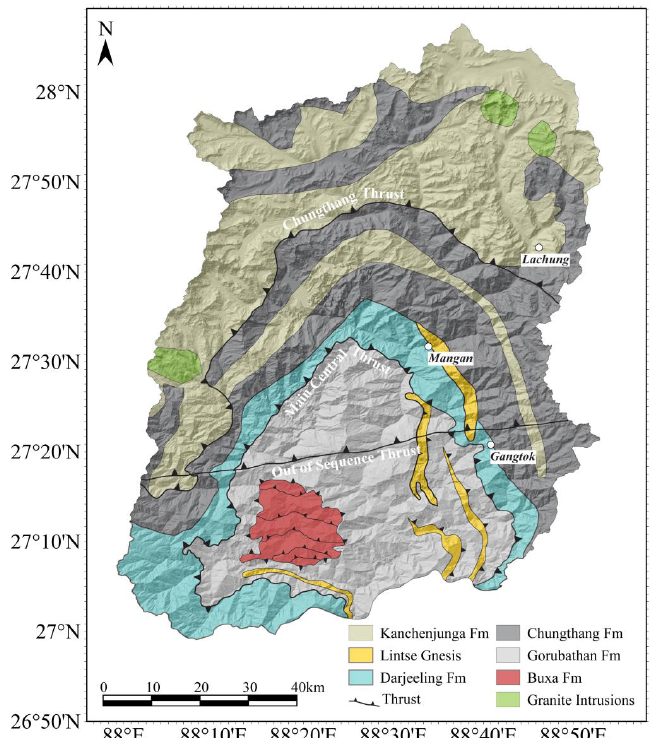
Figure 2. Geological map of the Sikkim Himalayas overlaying the transparent 30-m shaded topography (Fm: Formation) (Adapted from [23]).